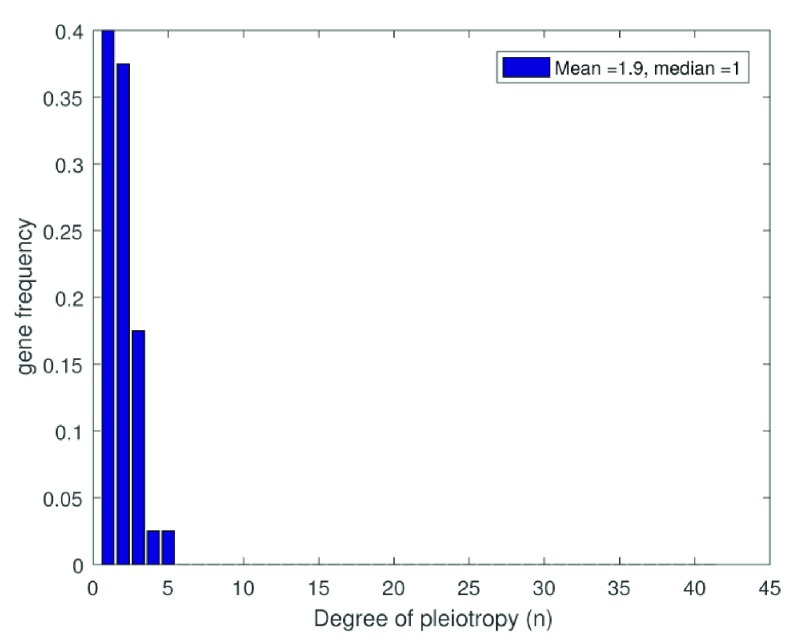
Frequency distributions of degree of gene pleiotropy for model (
2.4) with the parameters
N
g = 4000,
β = 4,
h = 0,
N
b = 3000.